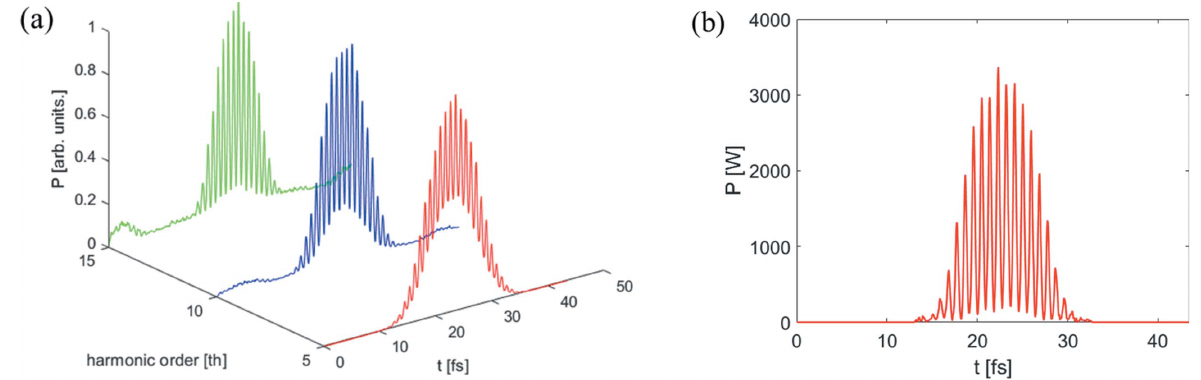
Figure 6 ( a ) Normalized radiation pulses at different harmonics from a 3 m-long radiator. ( b ) Longitudinal profile of the radiation pulse train at the 15th harmonic from a 2.5 m-long